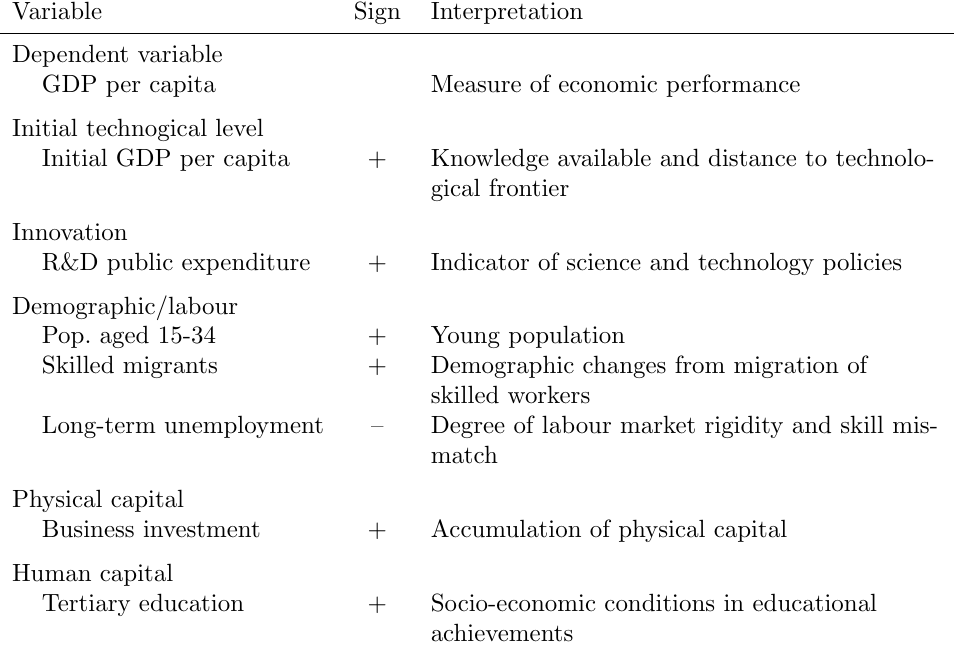
Table 1: Key variables and expected signs of the